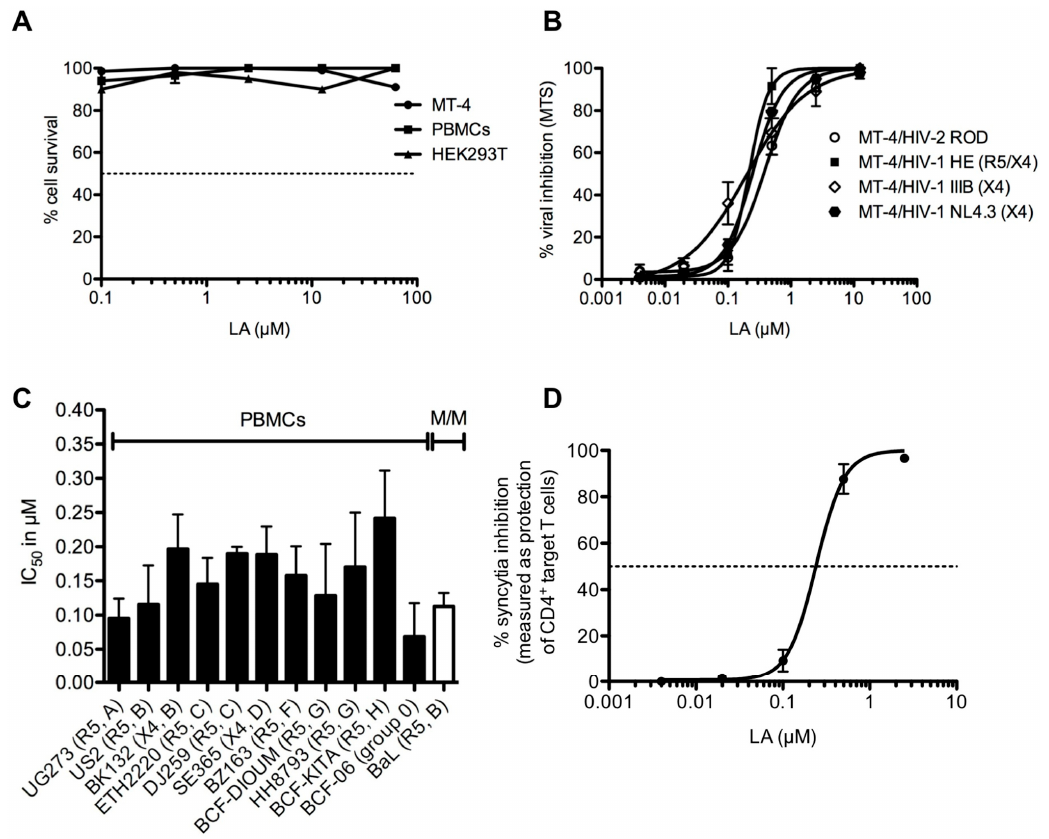
Figure 4. Cytotoxicity of Lignosulfonic acid (LA) on human T-cell leukemia cell line (MT-4) cells, human embryonic kidney cells (HEK293T) and peripheral blood mononuclear cells (PBMCs). ( A ) Dose dependent anti-HIV activity of LA in the CD4+ T-lymphoma cell line MT-4 against 3 laboratory HIV-1 strains (NL4.3, IIIB and HE) and 1 HIV-2 strain (ROD); ( B ) Evaluation of the IC50s of LA against various clinical isolates representing different of HIV-1 primary cells; ( C ) Dose-dependent effect of LA on the giant cell (syncytia) formation between persistently HIV-1 IIIB-infected T cells (HUT-78/IIIB) and non-infected CD4+ target SupT1 T cells; ( D ) Dashed lines correspond to 50%, (Reprinted with permission from [25]).